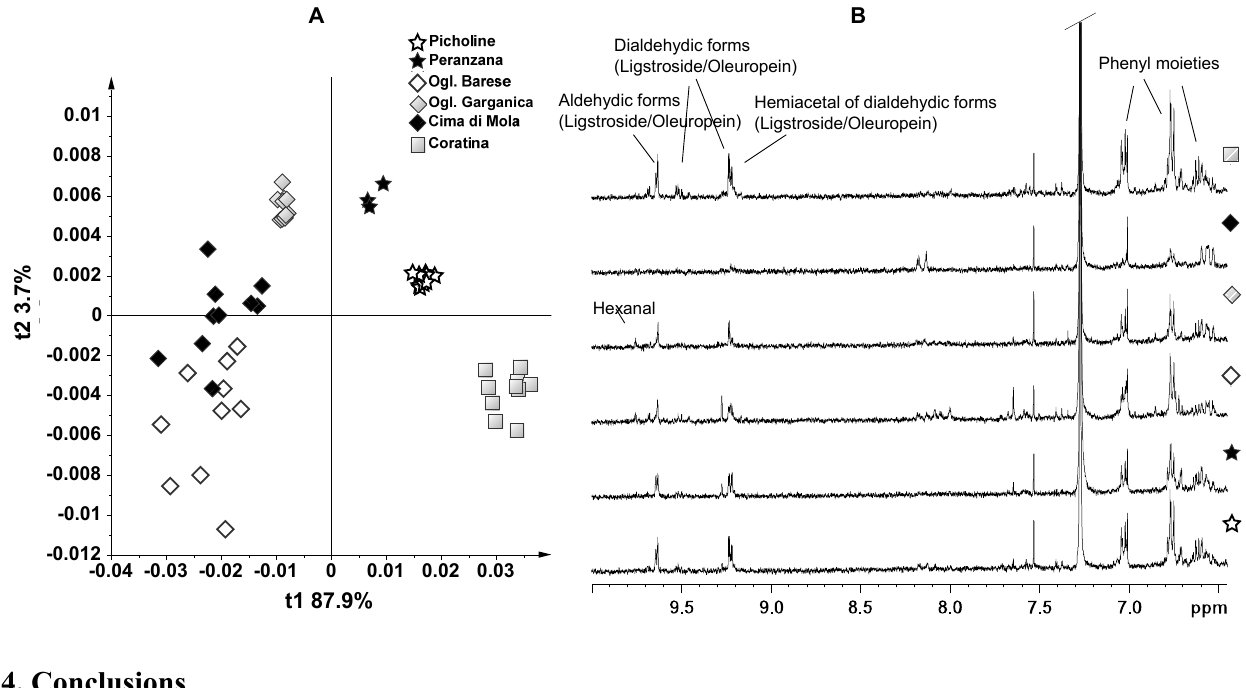
Figure 3. ( A ) PCA (t1/t2) score plot for monovarietal Apulian cultivar samples (native: Coratina, Ogliarola (Ogl.) Garganica, Ogliarola (Ogl.) Barese, Cima di Mola; recently introduced: Picholine and Peranzana). R 2 = 0.95 and Q 2 = 0.89; ( B ) expansions of the 1 H NMR spectra of monovarietal Apulian cultivars samples used for the